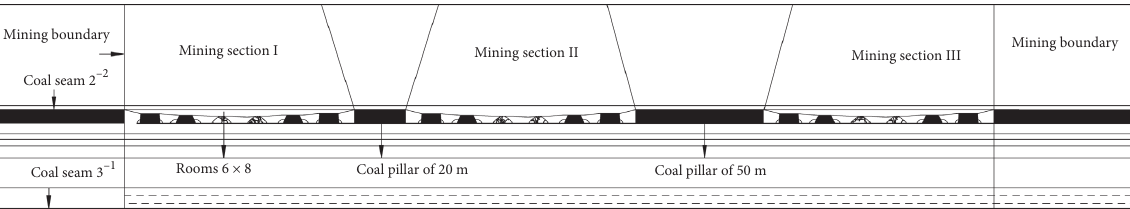
Figure 1: Characters of coal pillars in the room gob in coal seam 2 − 2 .